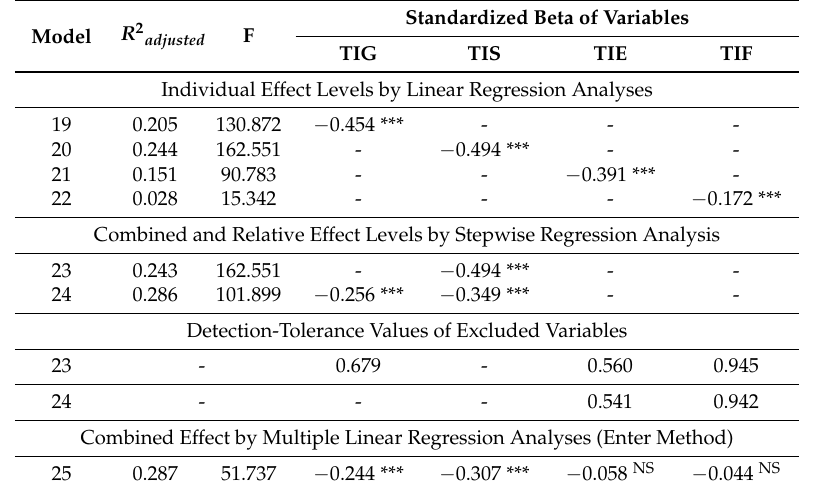
Table 8. Summary of individual effect levels by linear regression analyses, combined and relative effect levels by stepwise regression analysis of trust in the government, in social organizations, in experts, and in friends and relatives on